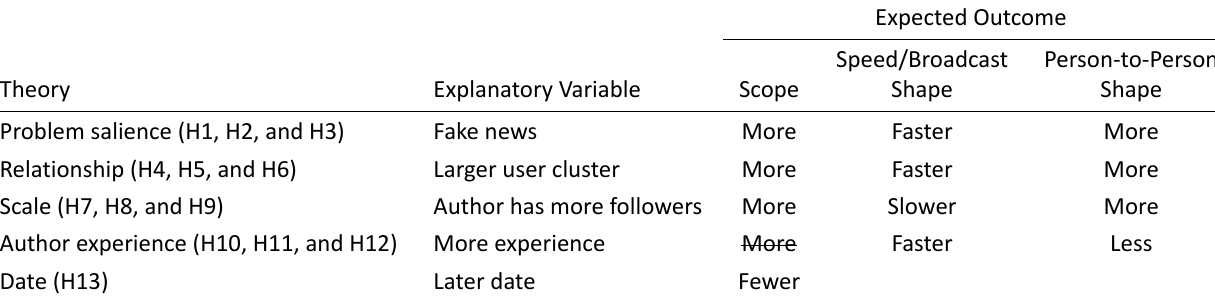
Table 1. Diffusion hypotheses (all supported except the strikethrough